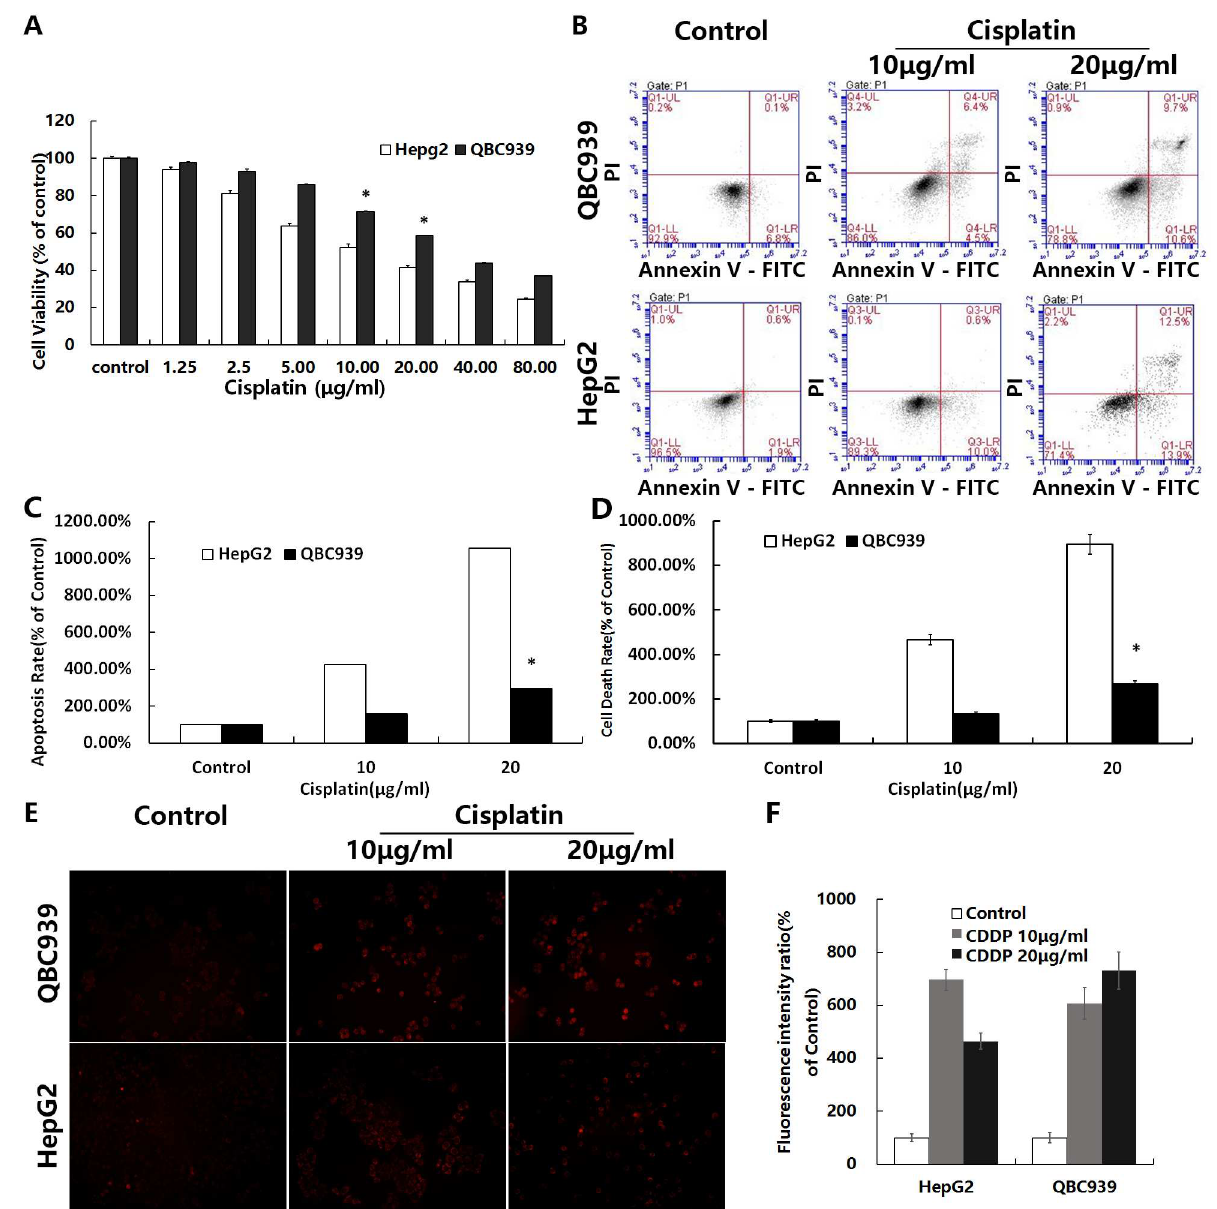
Fig 1. QBC939 cells are resistant to cisplatin. QBC939 and HepG2 cells were treated with cisplatinfor 12 or 24 h, and then cell viability, apoptosisand cell death rates, and mtROS were measured. (A) Cells were treated with cisplatin (1.25–80 μ g/ml) for 24 h and then cell viabilitywas determinedby MTT assays. (B) Cells were treated with cisplatin(10 or 20 μ g/ml) for 12 h and then the apoptoticrate was measuredby flow cytometry (fluorescence intensity: x axis, AnnexinV-FITC; y axis, PI). (C) Quantitationof the apoptosisrate (including early and late apoptosis)under the same treatment conditions as in (B). (D) Quantitation of the cell death rate by trypan blue stainingunder the same treatment conditions as in (B). (E) Cells were treated with cisplatin(20 μ g/ml) for 24 h followedby 5 μ m mitoSOX for 10 min, and then fluorescence intensity was observed by fluorescence microscopy( × 200). (F) Quantitationof the cell averagefluorescence intensity under the same treatment conditions as in (E). All values are the mean ± SE. * p < 0.05betweenQBC939 cells group and HepG2 cells group.